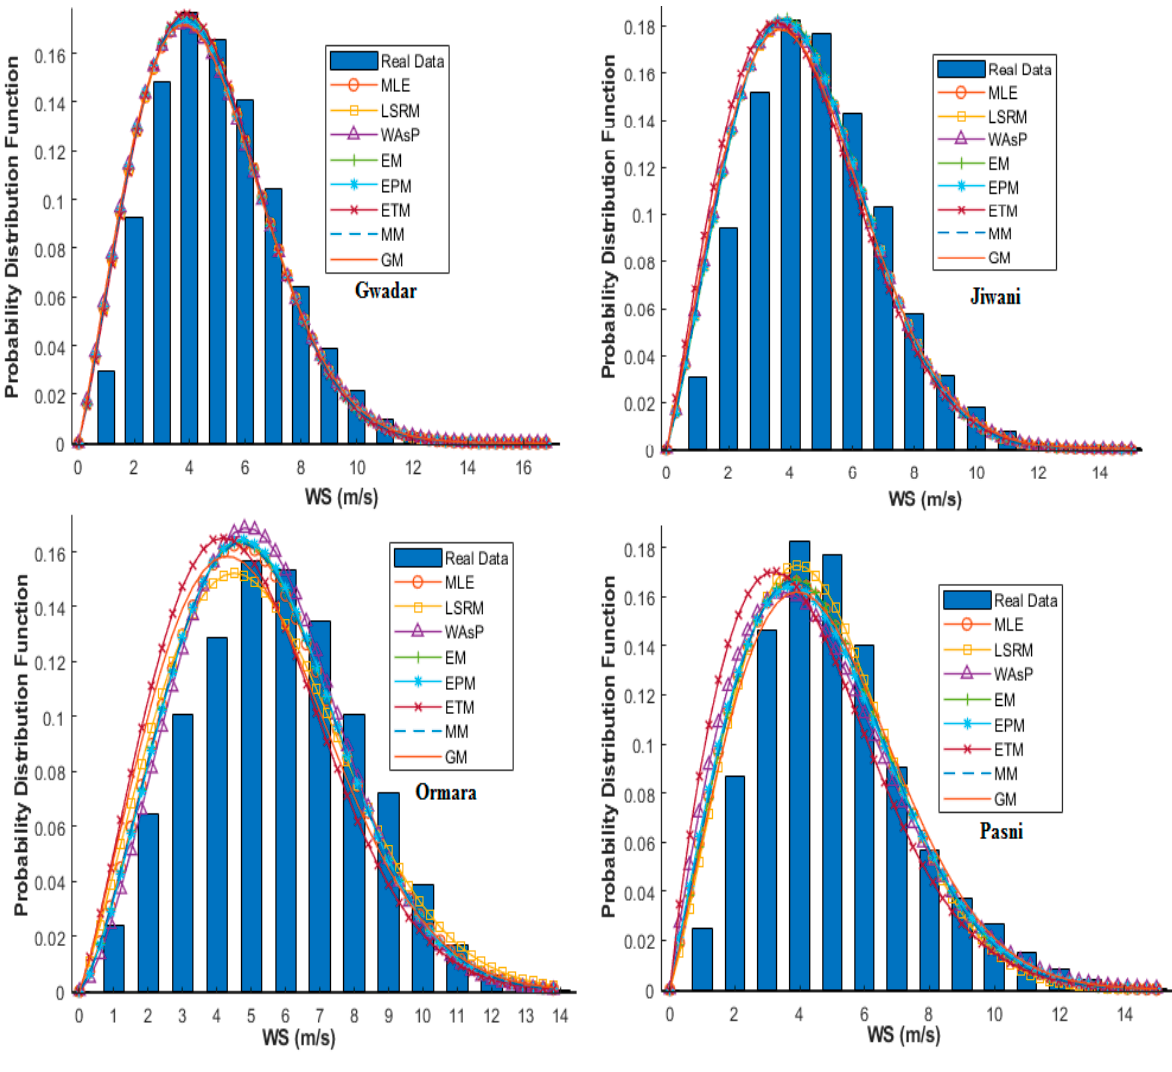
Figure 5. WD functions for all regions.